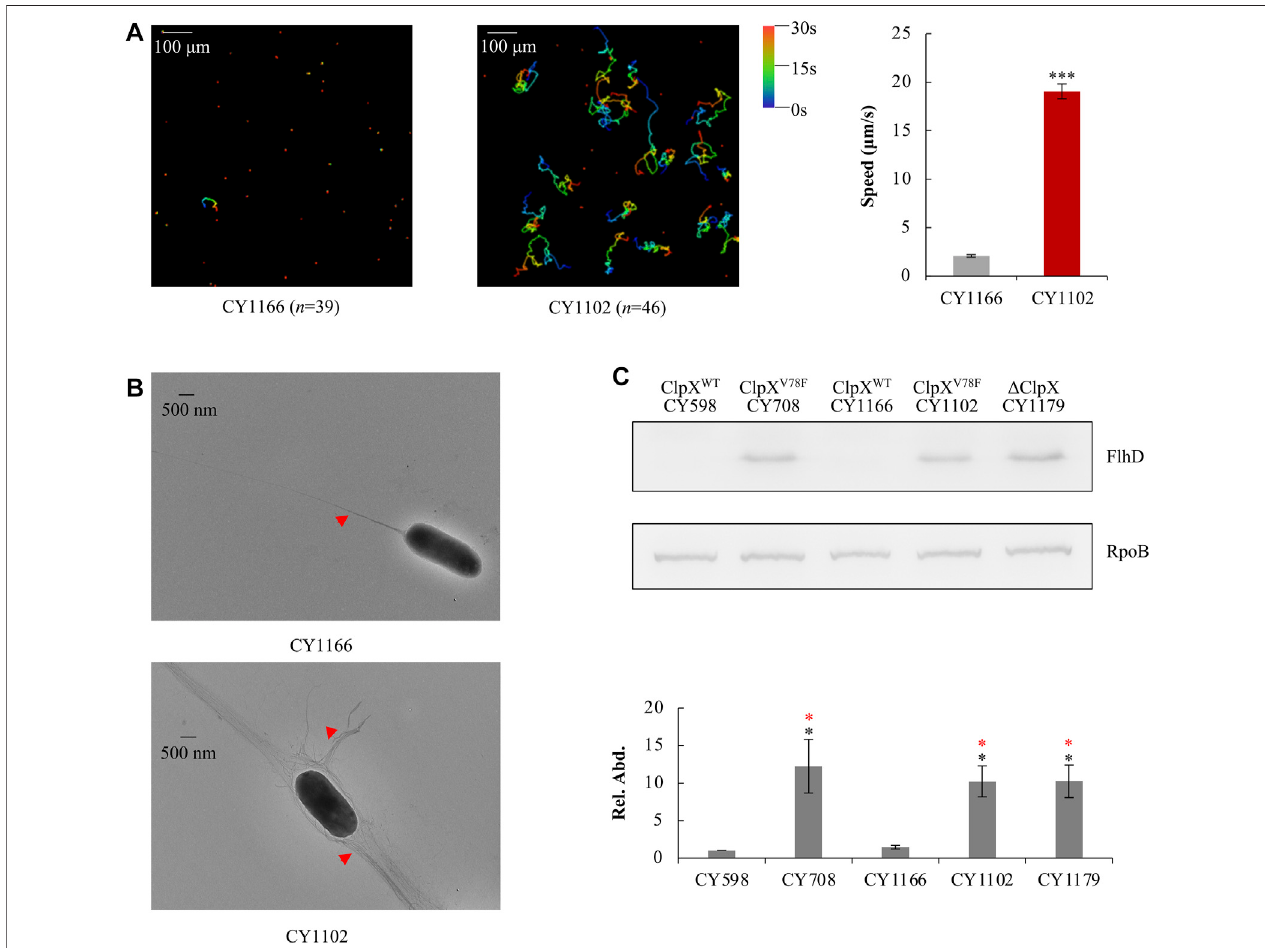
FIGURE 3 | Effect of ClpX V78F on FlhD accumulation in the hypermotile mutants. (A) Swimming speed of the two strains in liquid culture. The left plots showed the trajectoriesofthesingle-cellmovementofthetwostrains.Therainbowcolorsand “ n ” wereindicatedasshownin Figure1C .Theswimmingspeedwasexpressedasthe average ± S.E.M. in the right plots, calculated from 135 to 165 individual trajectories combined from three independent experiments. *** p ≤ 0.001 versus the swimming speed by CY1166. (B) Flagella production of single cells of the two strains. Image was shown as that in Figure 1E . (C) The protein levels of FlhD in the fi ve strains. RpoBwasusedasaloadingcontrol.Onerepresentativeresultofthewesternblotsisshownintheupperplot.TheproteinlevelofFlhDinCY598wasnormalizedto1,and thatinotherstrainswasdeterminedrelativetothisvalue.Therelativeproteinlevel(Rel.Abd.)isshownastheaverage ± S.E.M.ofthethreeindependentexperimentsinthe lower plot. * p ≤ 0.05 versus the relative protein level in CY598 (black) or CY1166 (red).